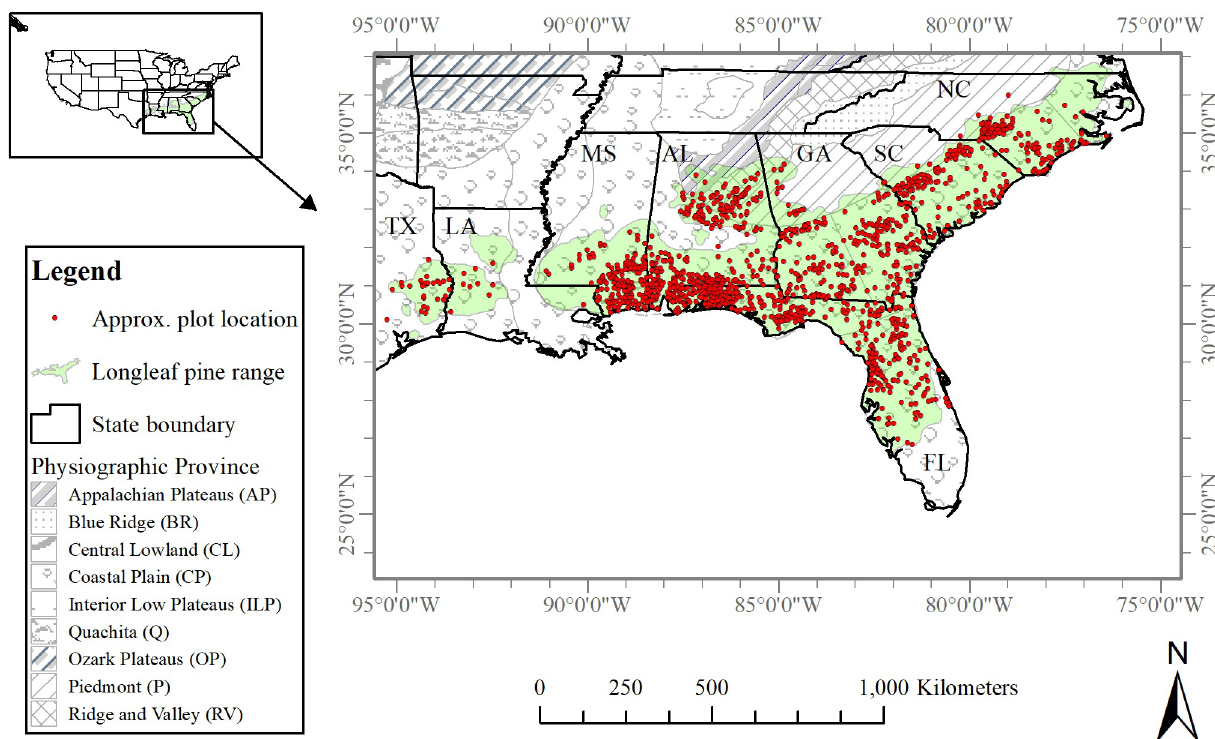
Fig 1. The study area was the range of longleaf pine in the states of Alabama (AL), Florida (FL), Georgia (GA), Louisiana (LA), Mississippi (MS), North Carolina (NC), South Carolina (SC) and Texas (TX). (Shapefile data sources: US state boundary [25], Physiographic Province [21], and Longleaf pine range